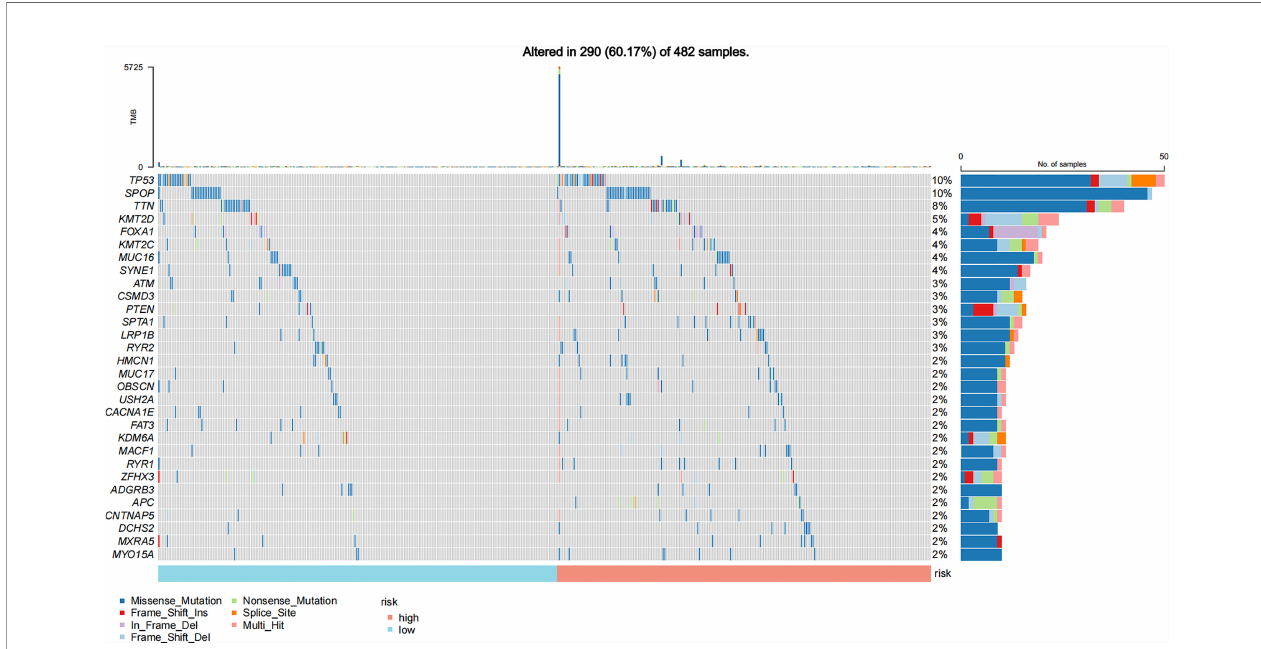
FIGURE 3 | Mutation information of the top 30 genes in the high-risk and low-risk GILncSig groups is shown in the waterfall plot; various colors with annotations on the bottom represent the different mutation types. The bar plot exhibits the tumor mutation burden